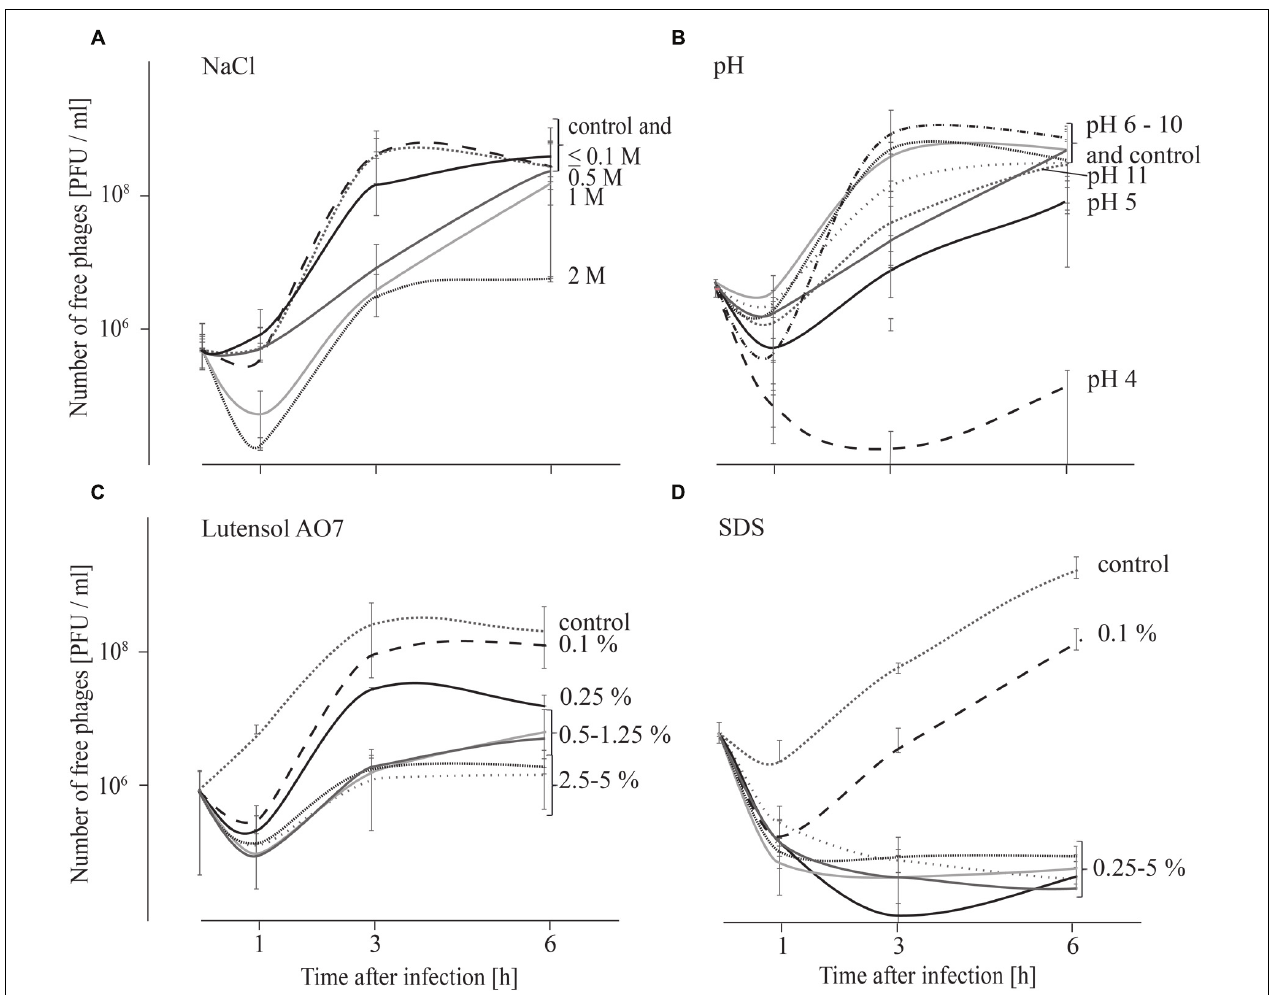
FIGURE 3 | Adsorption tests performed over 6 h in TSB media containing NaCl (A), adjusted to different pH values (B) and containing the detergents Lutensol AO 7 (C) or SDS (D). Graphs show the number of free (unattached extracellular) phages. All experiments were carried out twice and in duplicates and mean values and standard deviations are